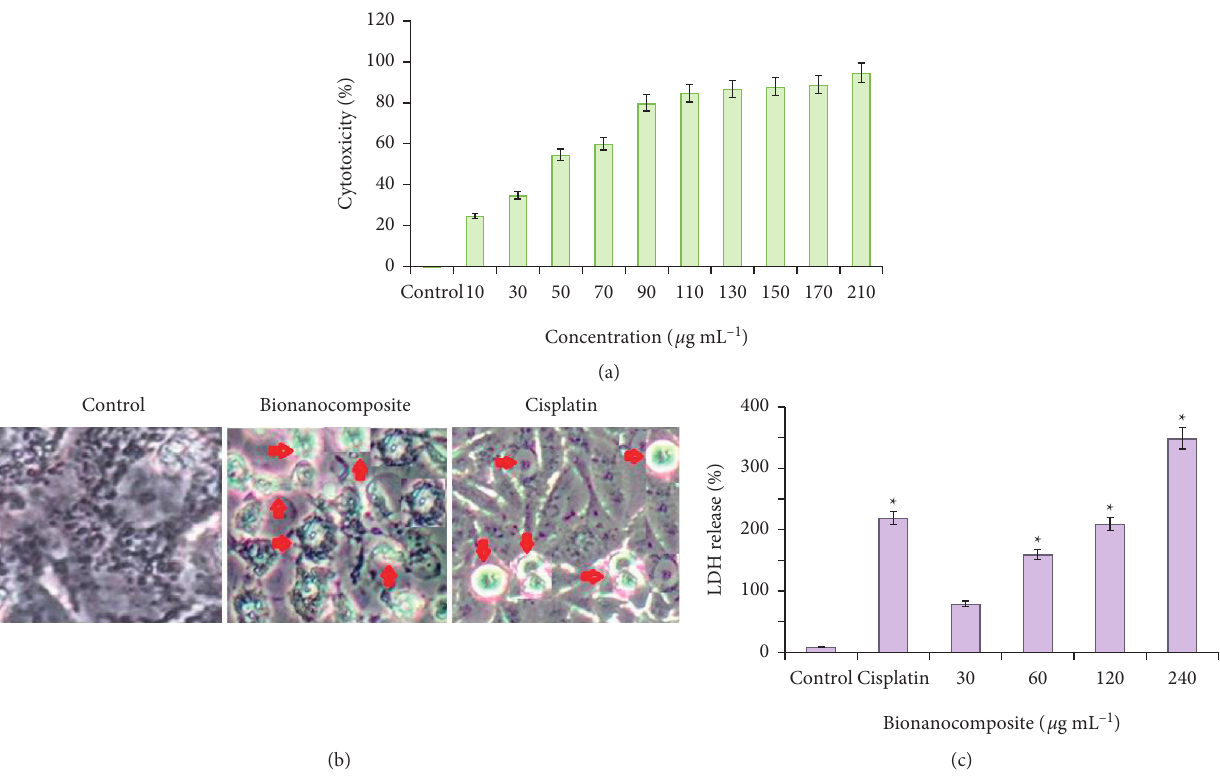
Figure 10: Antiproliferative activity of the polymeric bionanocomposite on A549 cells at 24h as assessed by the (a) MTTassay to evaluate cytotoxicity, (b) LDH leakage to evaluate membrane integrity, and (c) phase-contrast images demonstrating morphological changes. The arrowheads indicate that the cells have undergone apoptosis exhibiting characteristic features such as shrinkage of the cell, cell density reduction, and production of apoptotic bodies. The data are presented as mean ± SD of triplicate experiments. ∗ p < 0 . 05 expressed the statistically significant differences between the treated groups and